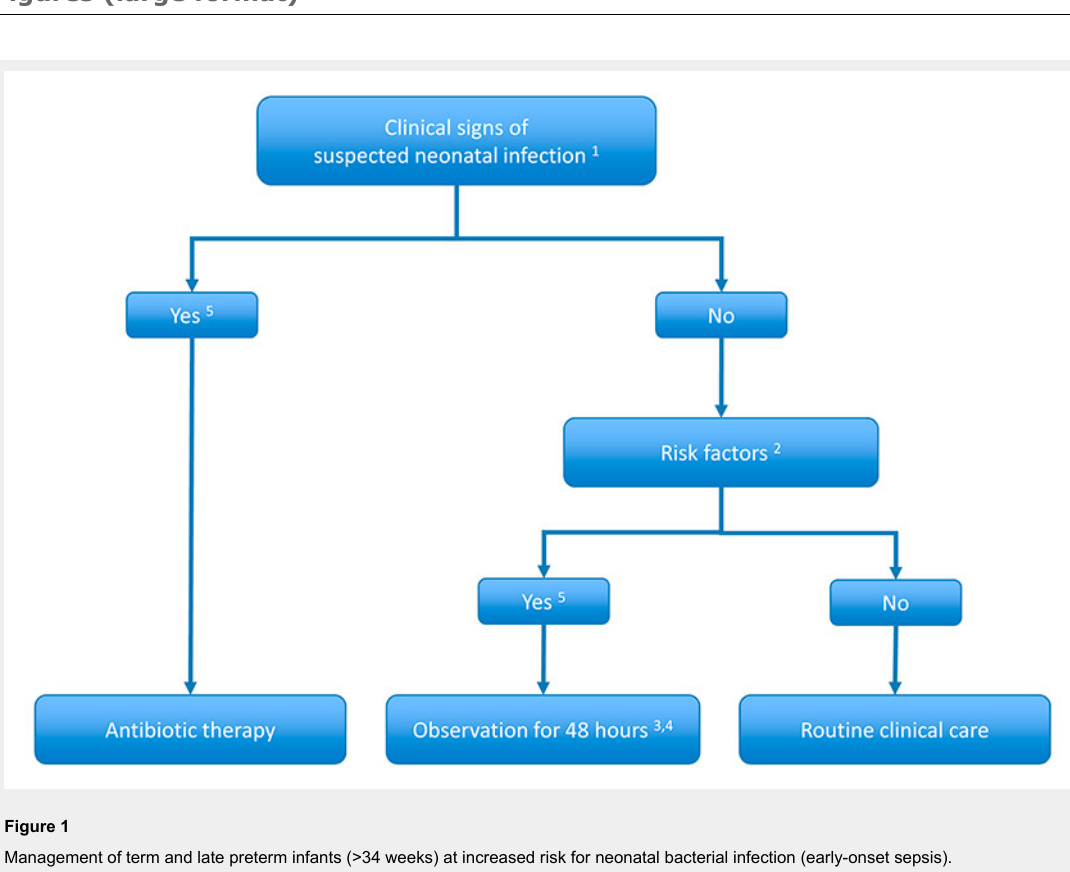
Management of term and late preterm infants (>34 weeks) at increased risk for neonatal bacterial infection (early-onset sepsis). (1.) Tachypnoea, respiratory distress, apnoea, tachycardia/bradycardia, poor peripheral perfusion, mottling, temperature instability, lethargy, irritability, changes in tone, vomiting, poor feeding. (2.) Maternal group B streptococcus (GBS) colonisation (vaginal/rectal swab: current or previous, bacteruria), preterm birth, prolonged rupture of membranes >18 hours, chorioamnionitis (maternal fever >38 °C plus two further symptoms: maternal leucocytosis, foetal tachycardia, painful or tender uterus, fetid amniotic fluid), required intrapartum prophylaxis missing or inadequate. (3.) Monitor vital signs every 4 hours: respiration, temperature, peripheral perfusion, colour. (4.) Elective Caesarean section (no rupture of membranes or contractions): no postnatal observation of baby necessary (regardless of maternal GBS status). (5.) If there are coexisting risk factors and/or the baby has clinical signs, discuss indication for laboratory tests with responsible